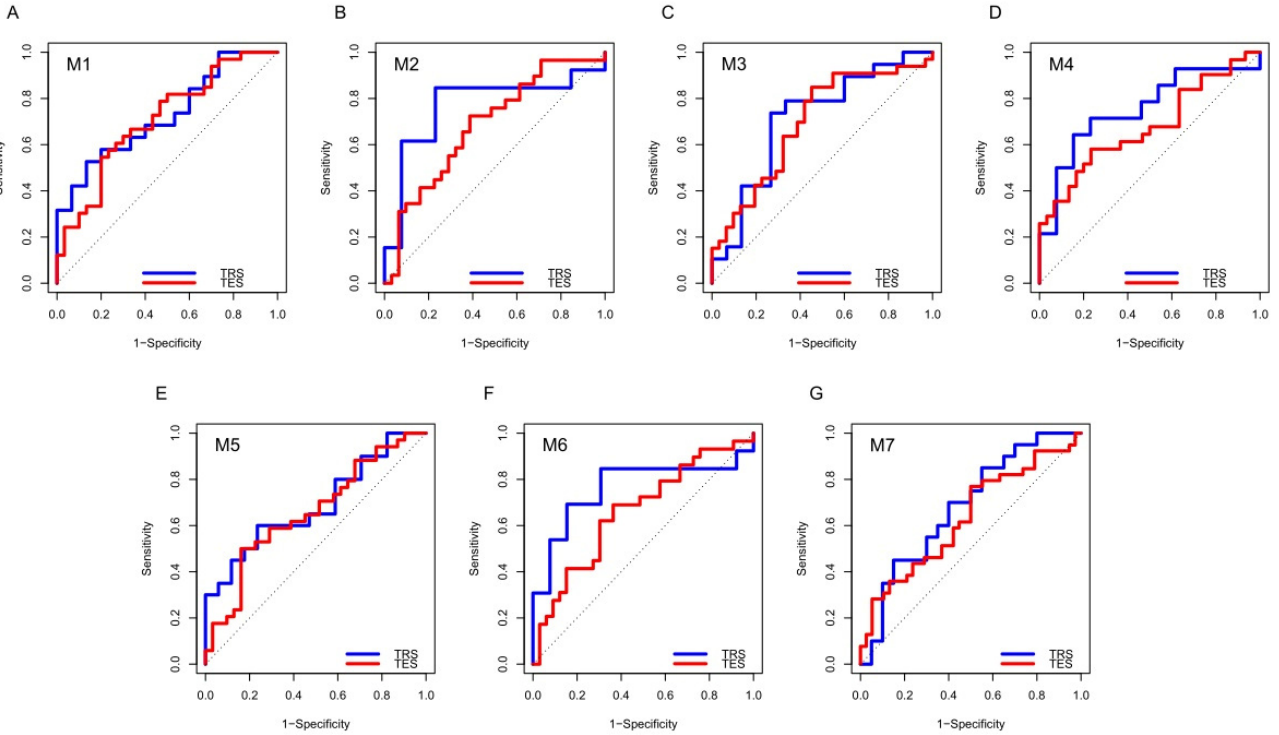
Figure 2. ROC curves of 7 miRNA-based signatures (M1–M7) in the TRS and TES sets. Each panel, ( A ): M1 signature; ( B ): M2 signature; ( C ): M3 signature; ( D ): M4 signature; ( E ): M5 signature; ( F ): M6 signature; ( G ): M7 signature, depicts the ROC curves of the 7 miRNA-based signatures in the training (TRS, in blue) and testing (TES, in red) sets of the Retrospective Cohort.